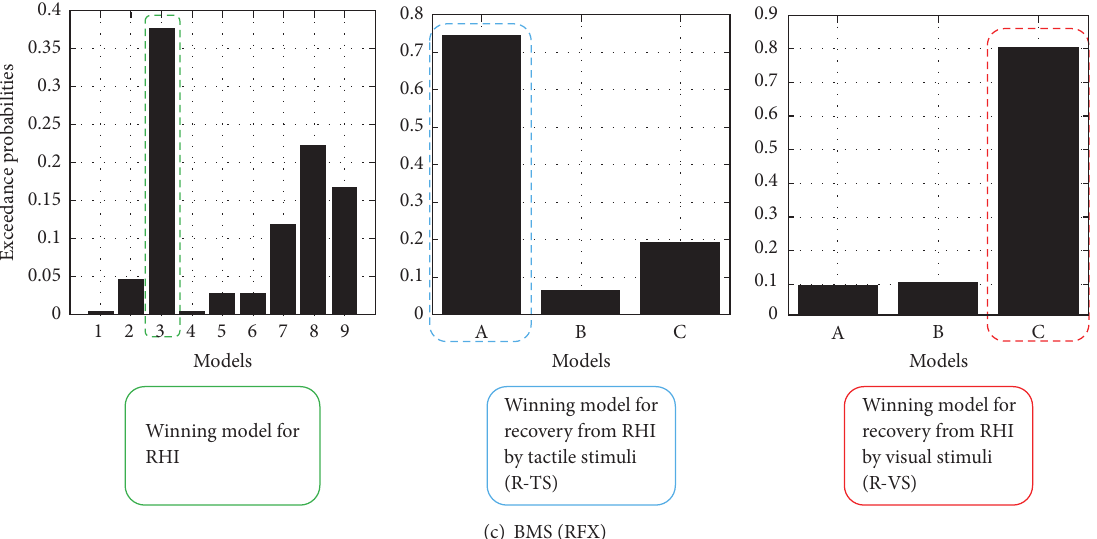
Figure 2: (a) Dynamic causal modeling (DCM) for the RHI (9 models). Blank arrow indicates endogenous connection, and solid arrow indicates modulatory effect. (b) DCM for recovery from the RHI by needle rotation in the real hand (R-TS, 3 models) and in the rubber hand (R-VS, 3 models). Winning models from the random-effects Bayesian model selection for each DCM analysis are marked with a box: Model 3 for the RHI, Model A for recovery from the RHI by tactile stimuli, and Model C for recovery from the RHI by visual stimuli. Winning Model 3 for the RHI was used in DCM analyses for R-TS and R-VS in which the driving inputs from mechanical stimulation were differentially defined as entering into the SII (Model A), into the LOC (Model B), and into the SII and the LOC (Model C). (c) Bayesian model selection (BMS), winning model, and parameter